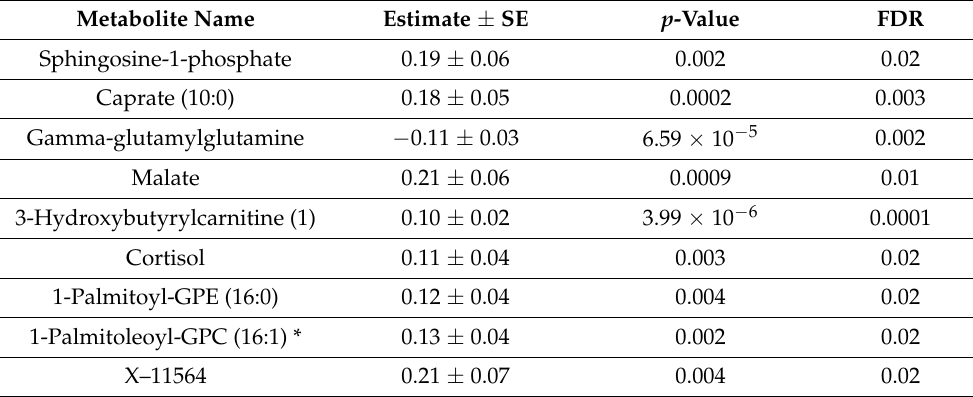
Table 3. Replicated metabolites in PEAR European